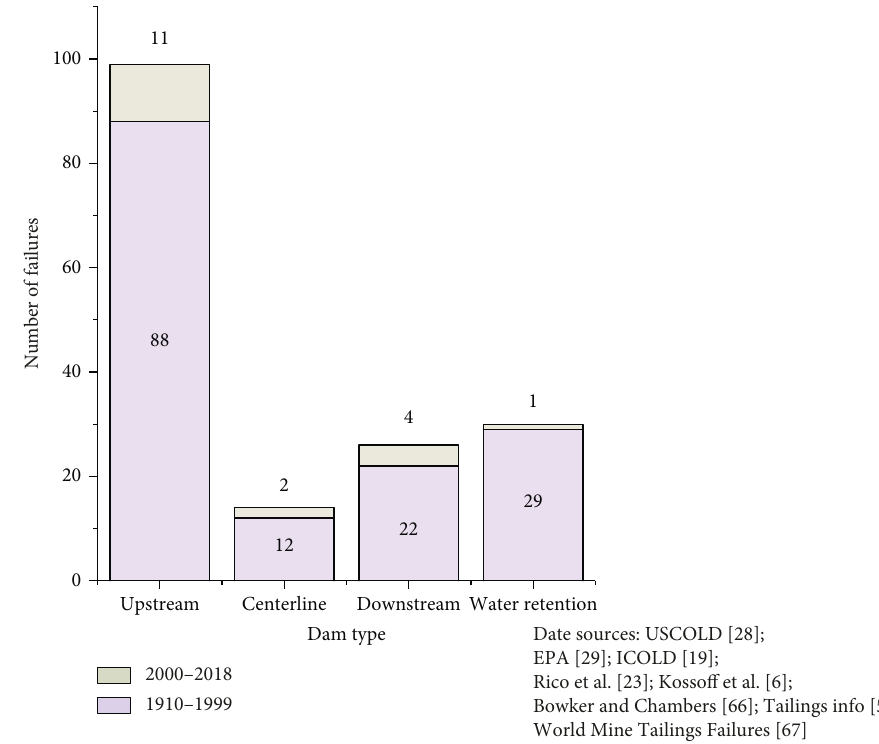
Figure 8: Failure distribution by the tailings dam